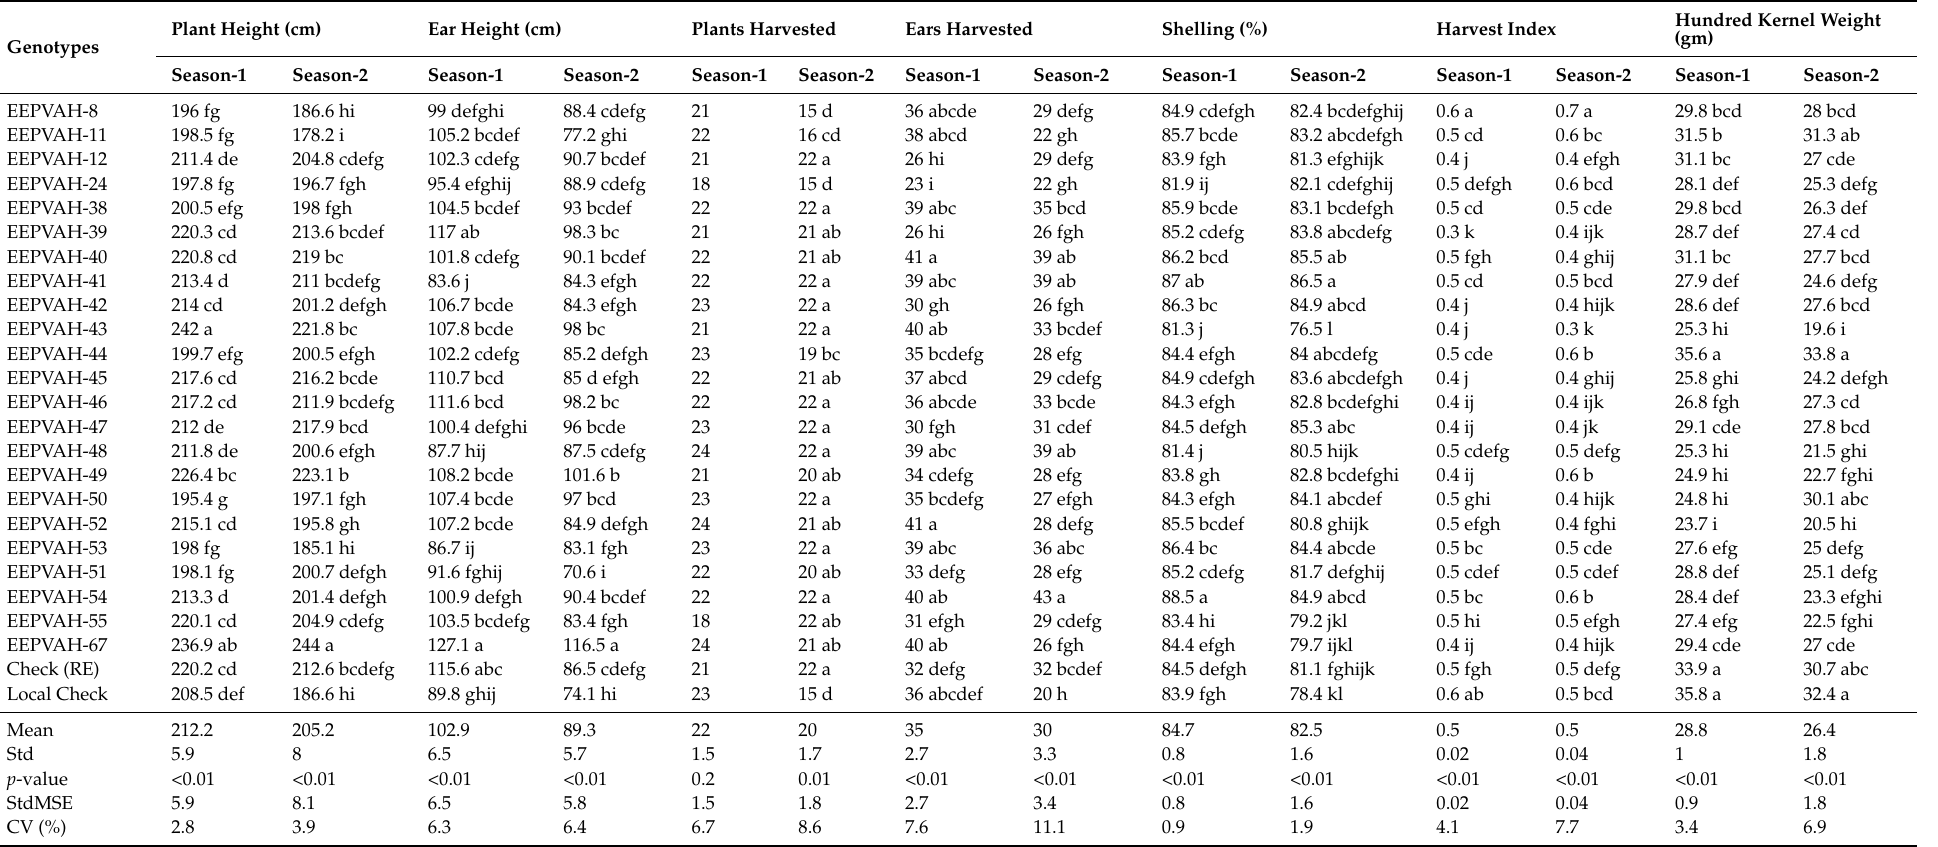
Table 4. Growth and yield attributing traits recorded in provitamin A biofortified maize genotypes from the two contrasting